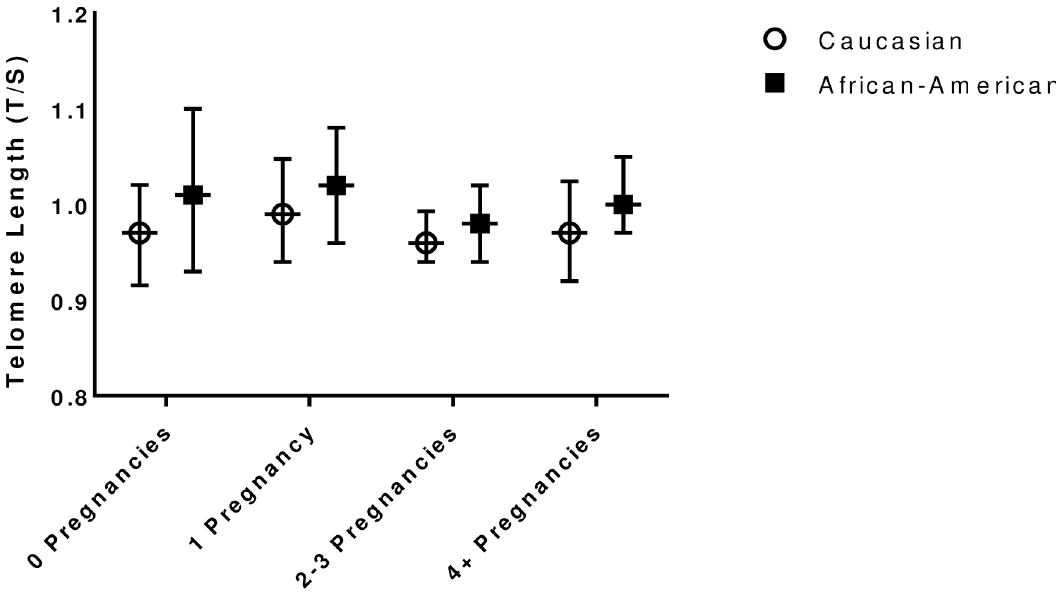
Fig 2. Telomere length (mean and 95% CI) by gravidity group in Caucasian and African-American women. There were no differences in unadjusted telomere length betweengravidity groups in either race.